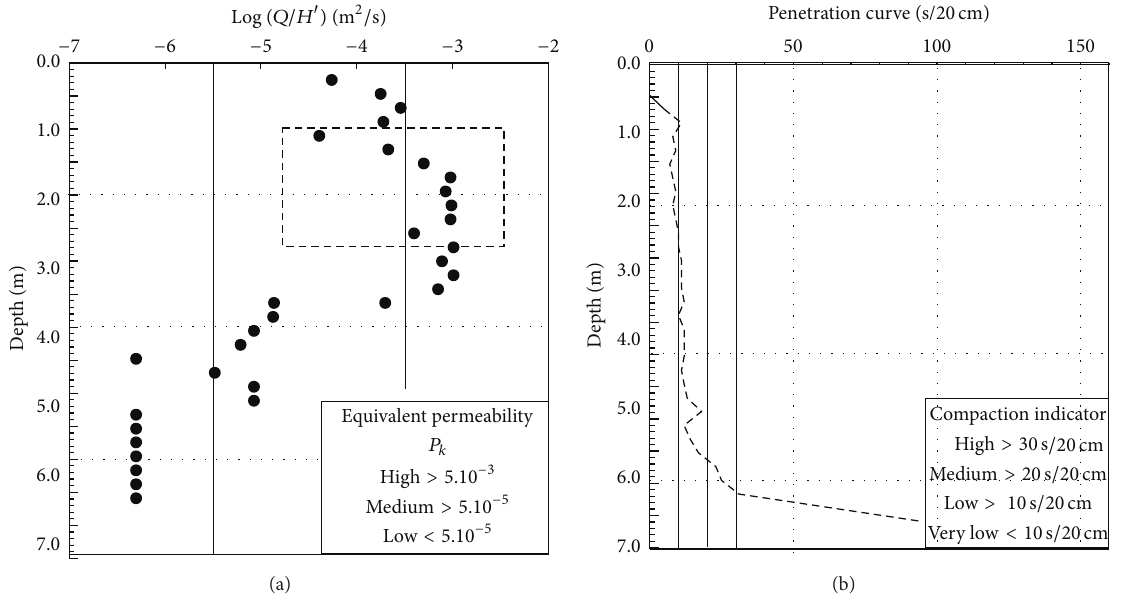
Figure 14: (a) Equivalent permeability 𝑃 𝑘 obtained with the Perm´eafor located on S1 and (b) associated penetration curve.